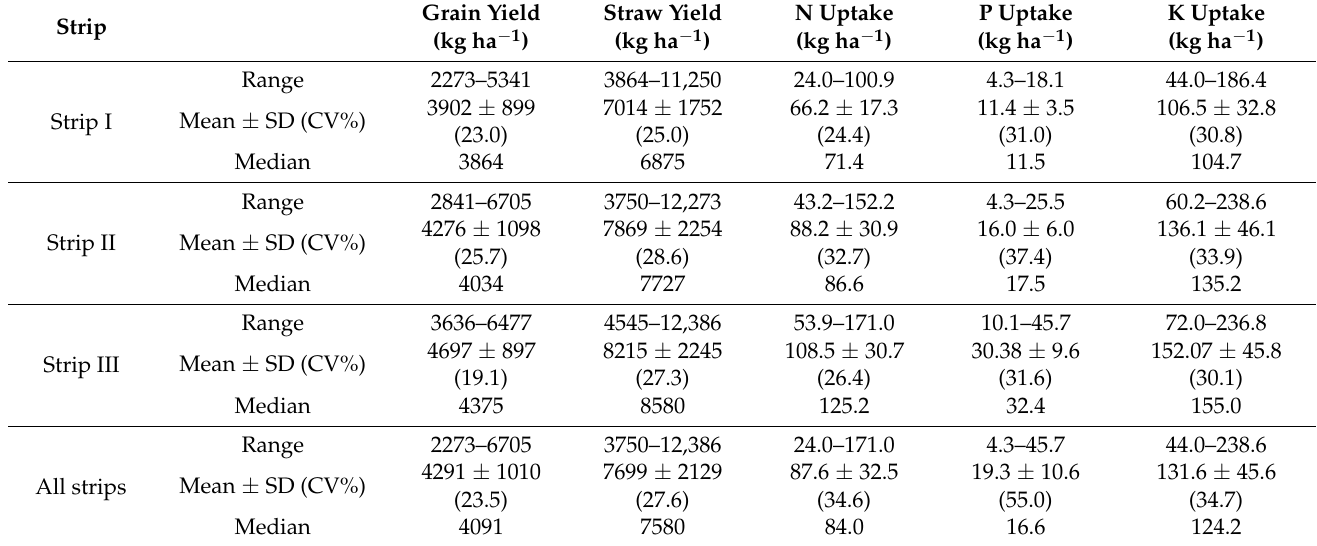
Table 4. Descriptive statistics of DSR GY and nutrient